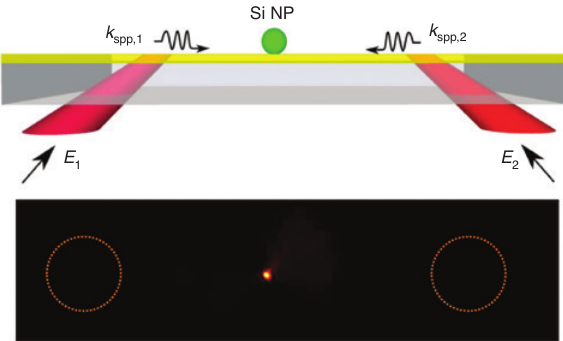
Figure 11: Frequency mixing in a nanoscopic Si particle with surface